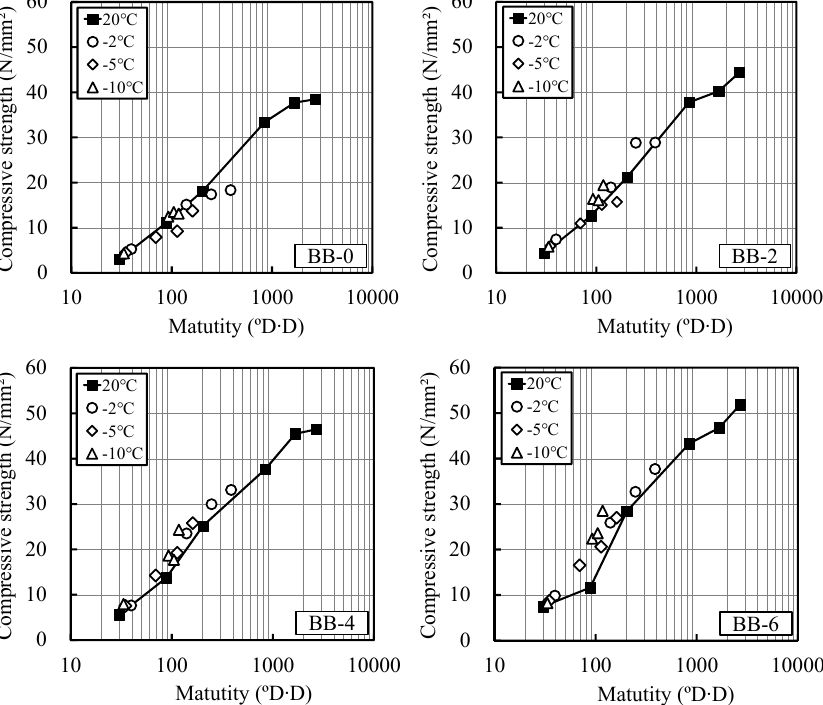
Figure 4. Relation between maturity and compressive strength (BB): Previous equation for maturity, ( a ) BB-0;( b )BB-2;( c )BB-4;( d )BB-6.